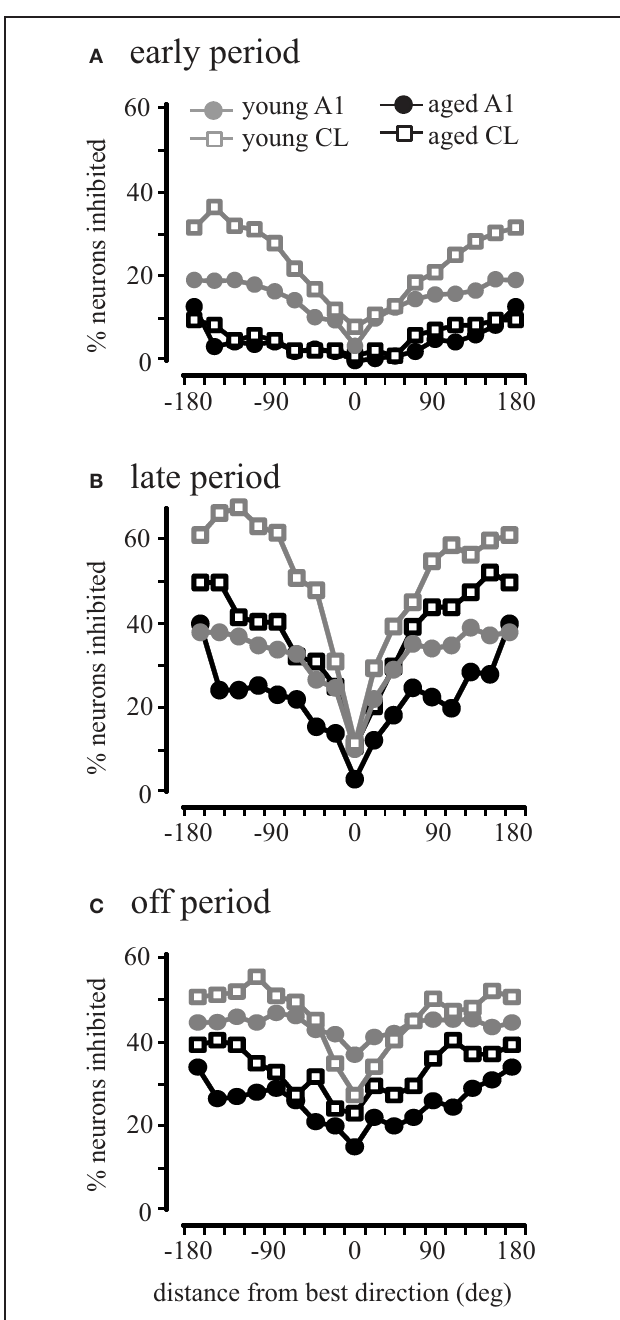
FIGURE 7 | Percentage of neurons inhibited during different periods of the response. Very few cells showed inhibition during the early period of aged monkeys in both A1 and CL (Panel A ) compared to younger animals. Similar results were seen for the late period (B) and the off period (C)